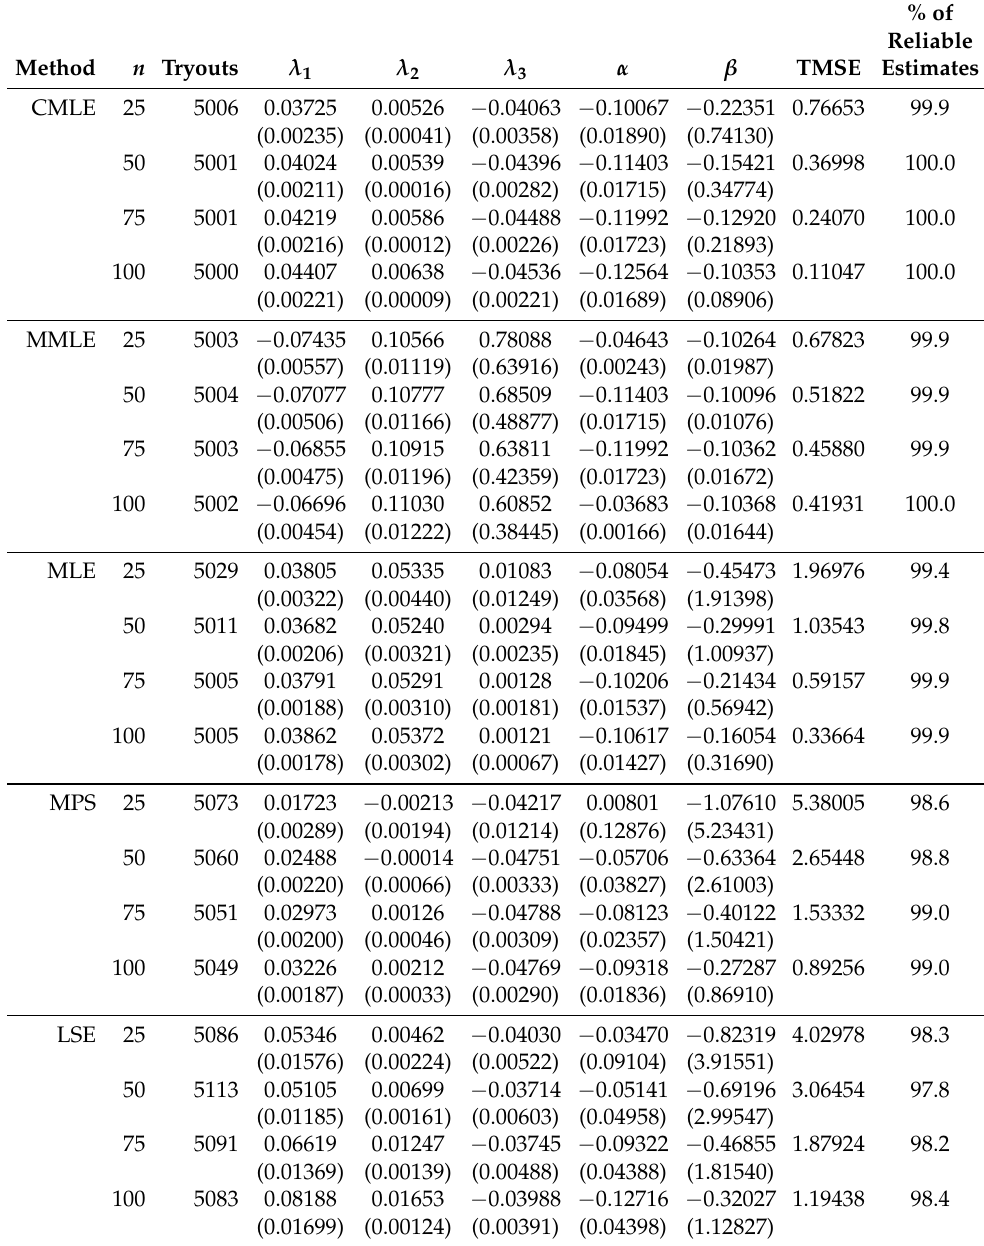
Table 1. Simulated biases and MSEs (in parentheses) of the parameter estimates obtained based